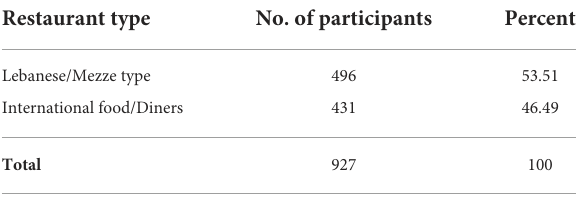
TABLE 2 Restaurants classification based on the menu